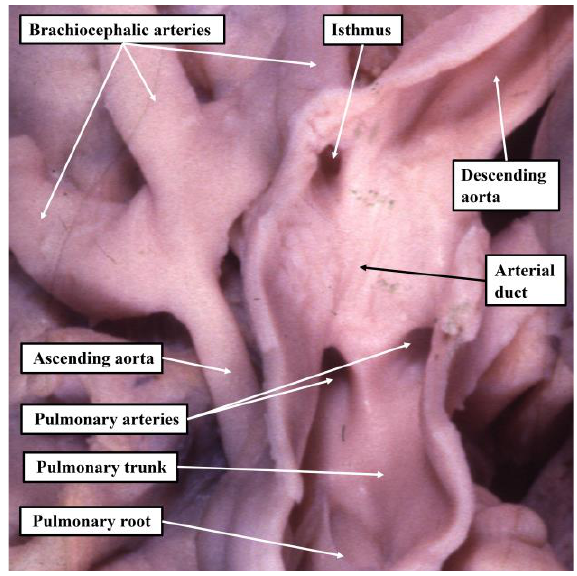
Figure 3. The image shows the characteristic feature of the intrapericardial arterial trunks and the extrapericardial pathways in the hearts grouped together by Lev as having hypoplasia of the aortic outflow tract complex. The major pathway from the heart is through the pulmonary trunk and the arterial duct. The aortic pathway is fed in retrograde fashion through the mouth of the aortic isthmus, which itself is encircled by ductal tissue.